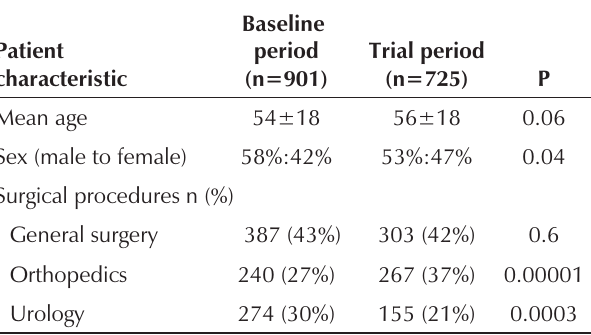
Patient demographics for patients eligible for perioperative antimicrobial prophylaxis during baseline and trial periods